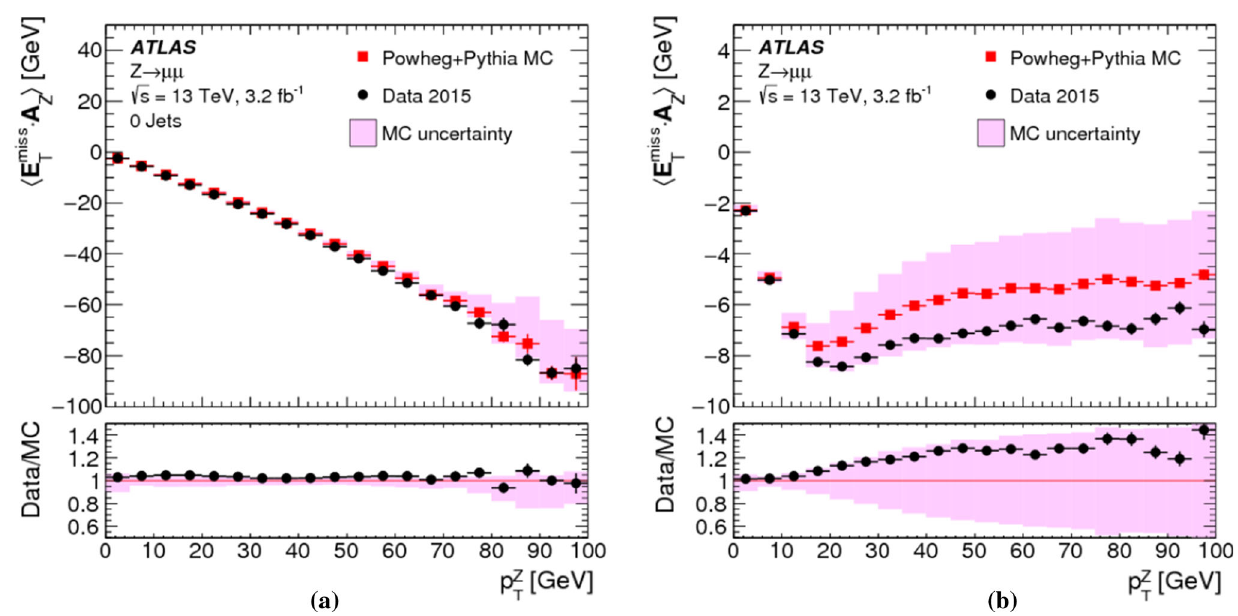
Fig. 4 The average projection of E miss onto the direction A Z of the Z tions are shown below the plots. The shaded areas indicate the overall T statistical uncertainty combined with systematic uncertainties compris- boson’s transverse momentum vector p Z , as given in Eq. (10), is shown T ing contributions from the muon and soft-term systematic uncertainties = | p Z | in Z → μμ events from a the N = 0 sam- as a function of p Z jet T T in a , and including the additional jet systematic uncertainties in b , for ple and from b the inclusive sample. In both cases data are compared to MC simulations MC simulations. The ratio of the averages from data and MC simula-